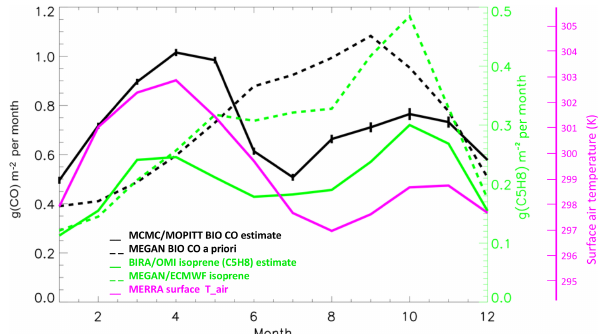
Figure 4. Average monthly CO (black) and C 5 H 8 (green) fluxes and surface air temperatures (magenta) for 2005–2012 for the North African savannas region (see inset map in Fig. 2). Solid black and green lines show the posterior “top-down” fluxes while dashed black and green lines show the emissions predicted by MEGAN with associated meteorological